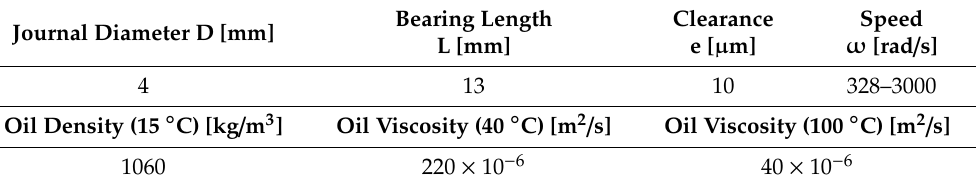
Figure 2. The studied bearing. Table 1. Bearing